Question: Compose a caption that would accompany this figure in a paper.
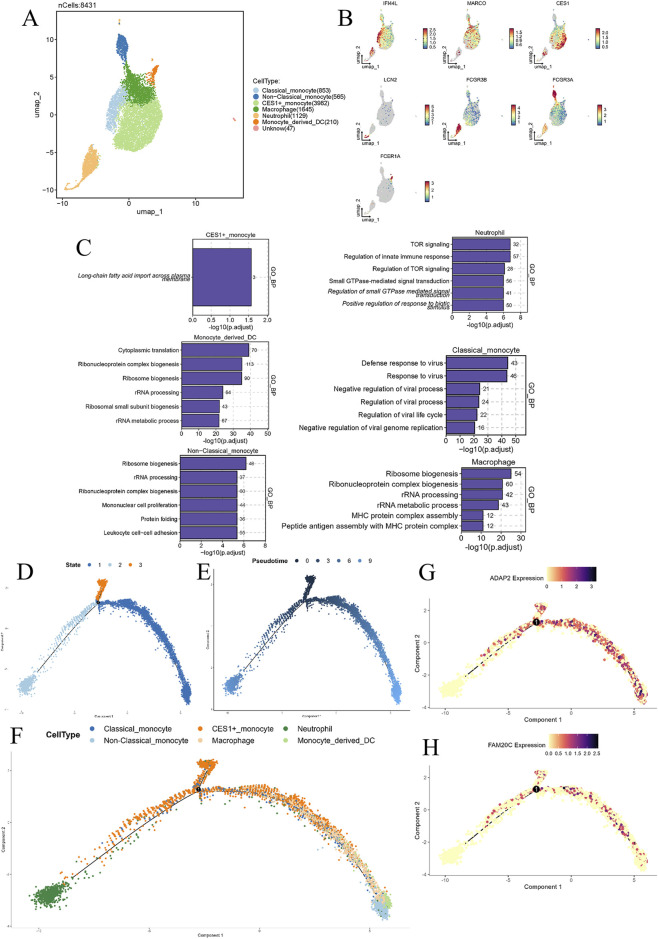
Answer: The roles of ADAP2 and FAM20C in myeloid cells. (A) UMAP plot showing the sub-clustering of myeloid cell subsets. (B) Expression distribution of characteristic marker genes across the myeloid cell subsets. (C) Results of GO biological process enrichment analysis for each myeloid cell subset. (D) Distribution of myeloid cell states along the differentiation trajectory. (E) Trajectory path of cells based on pseudotime. (F) Trajectory illustrating cell differentiation towards terminal states, corresponding to specific myeloid cell subtypes. (G,H) Expression patterns of the core genes ADAP2 (G) and FAM20C (H) along the myeloid cell differentiation trajectory.